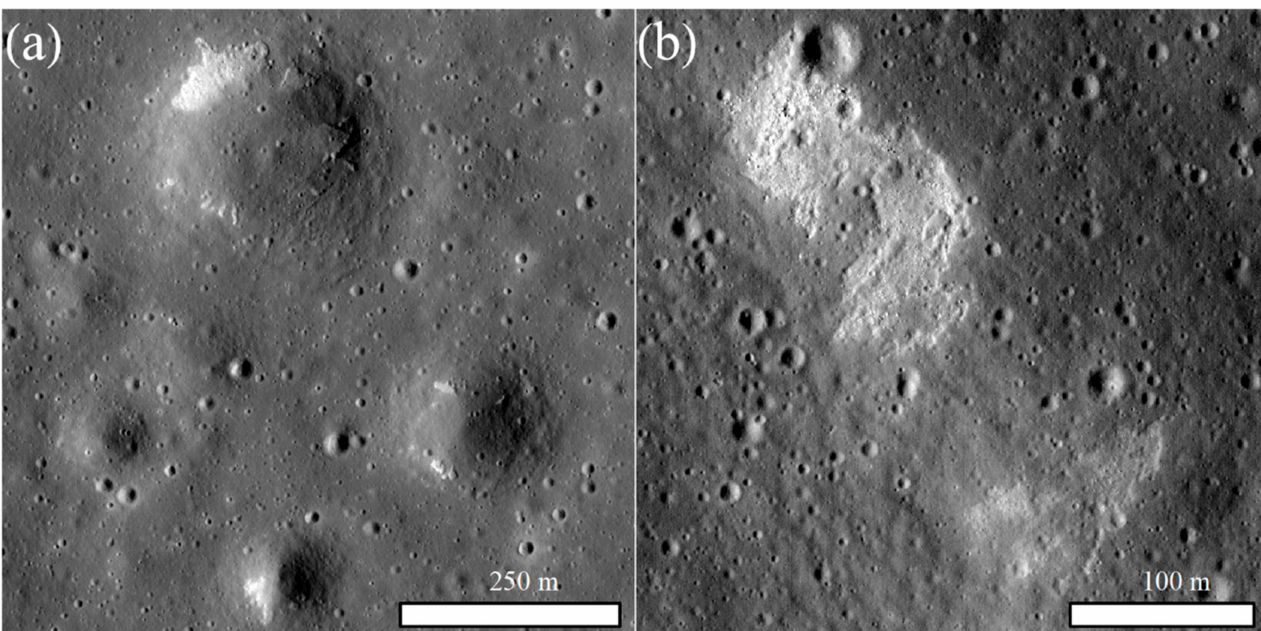
Figure 8. Two sites of IMP in Mare Fecunditatis, shown with Narrow Angle Camera (NAC, [13]) images. ( a ) IMPs next to the crater rim (2.02 ◦ S, 43.31 ◦ E); ( b ) IMPs on the mare (0.09 ◦ N, 42.41 ◦ E). Data source: NAC M1230441915RE and NAC M150239673LE.